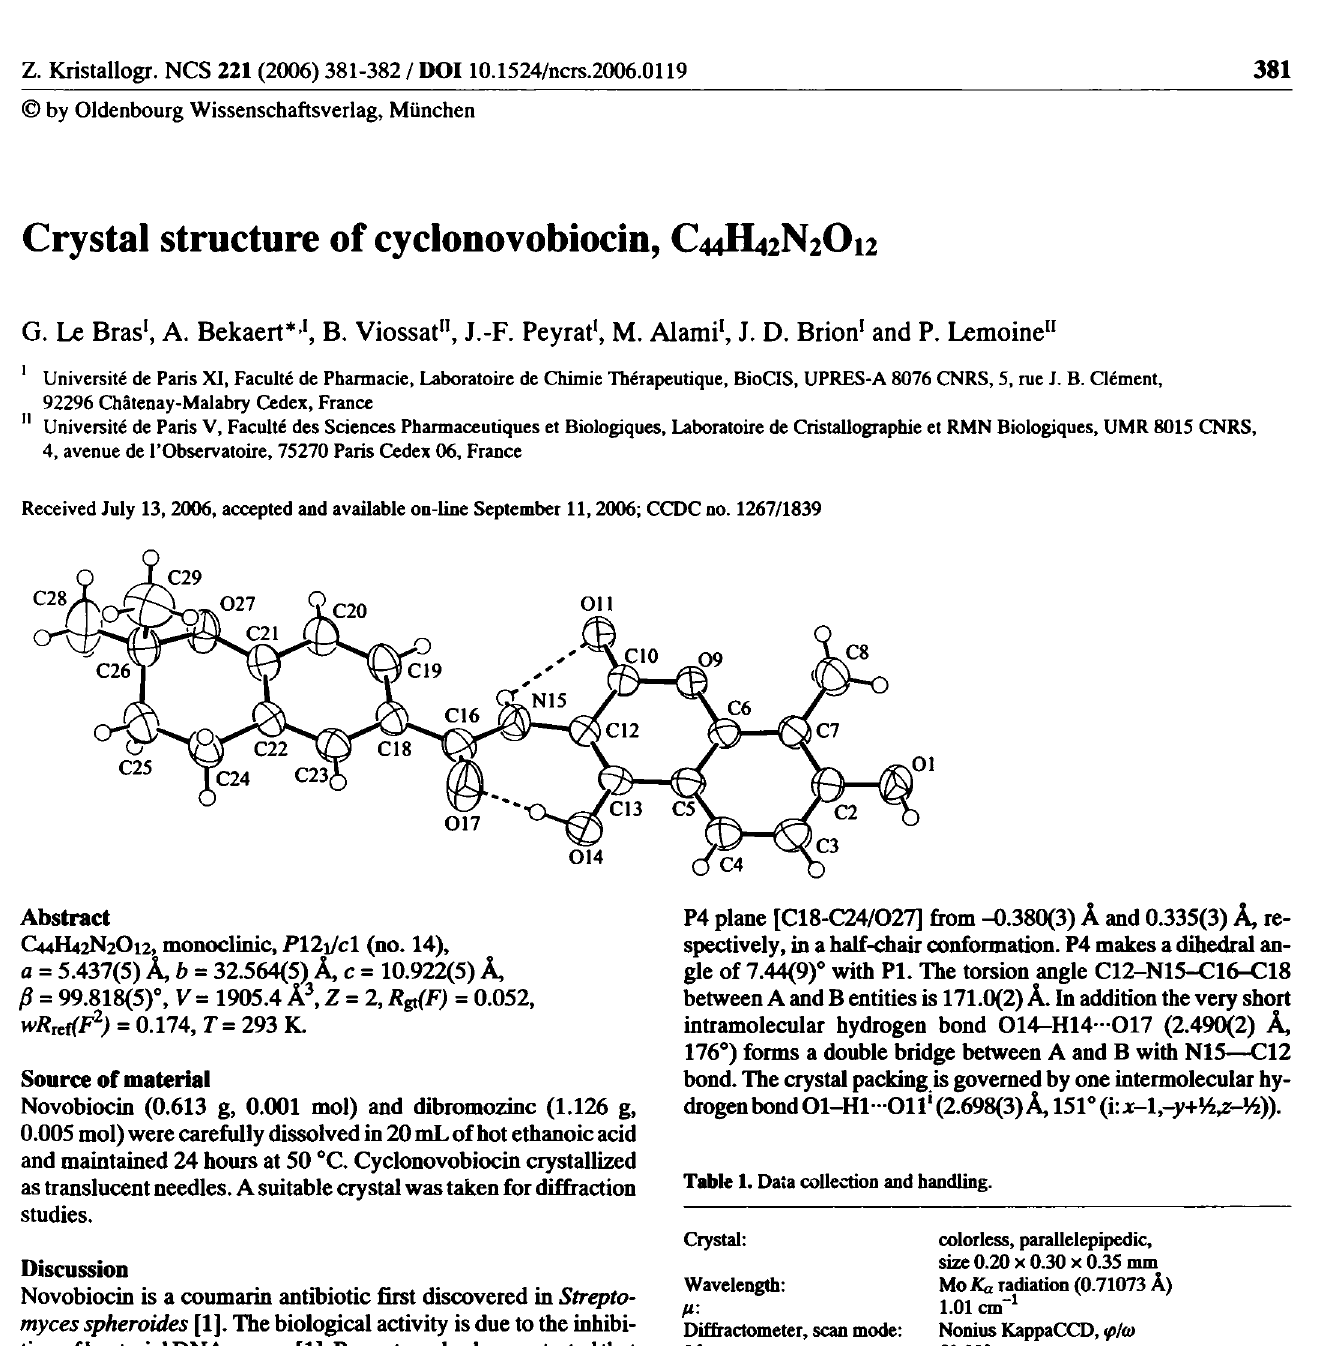
Table 2. Atomic coordinates and displacement parameters (in A 2